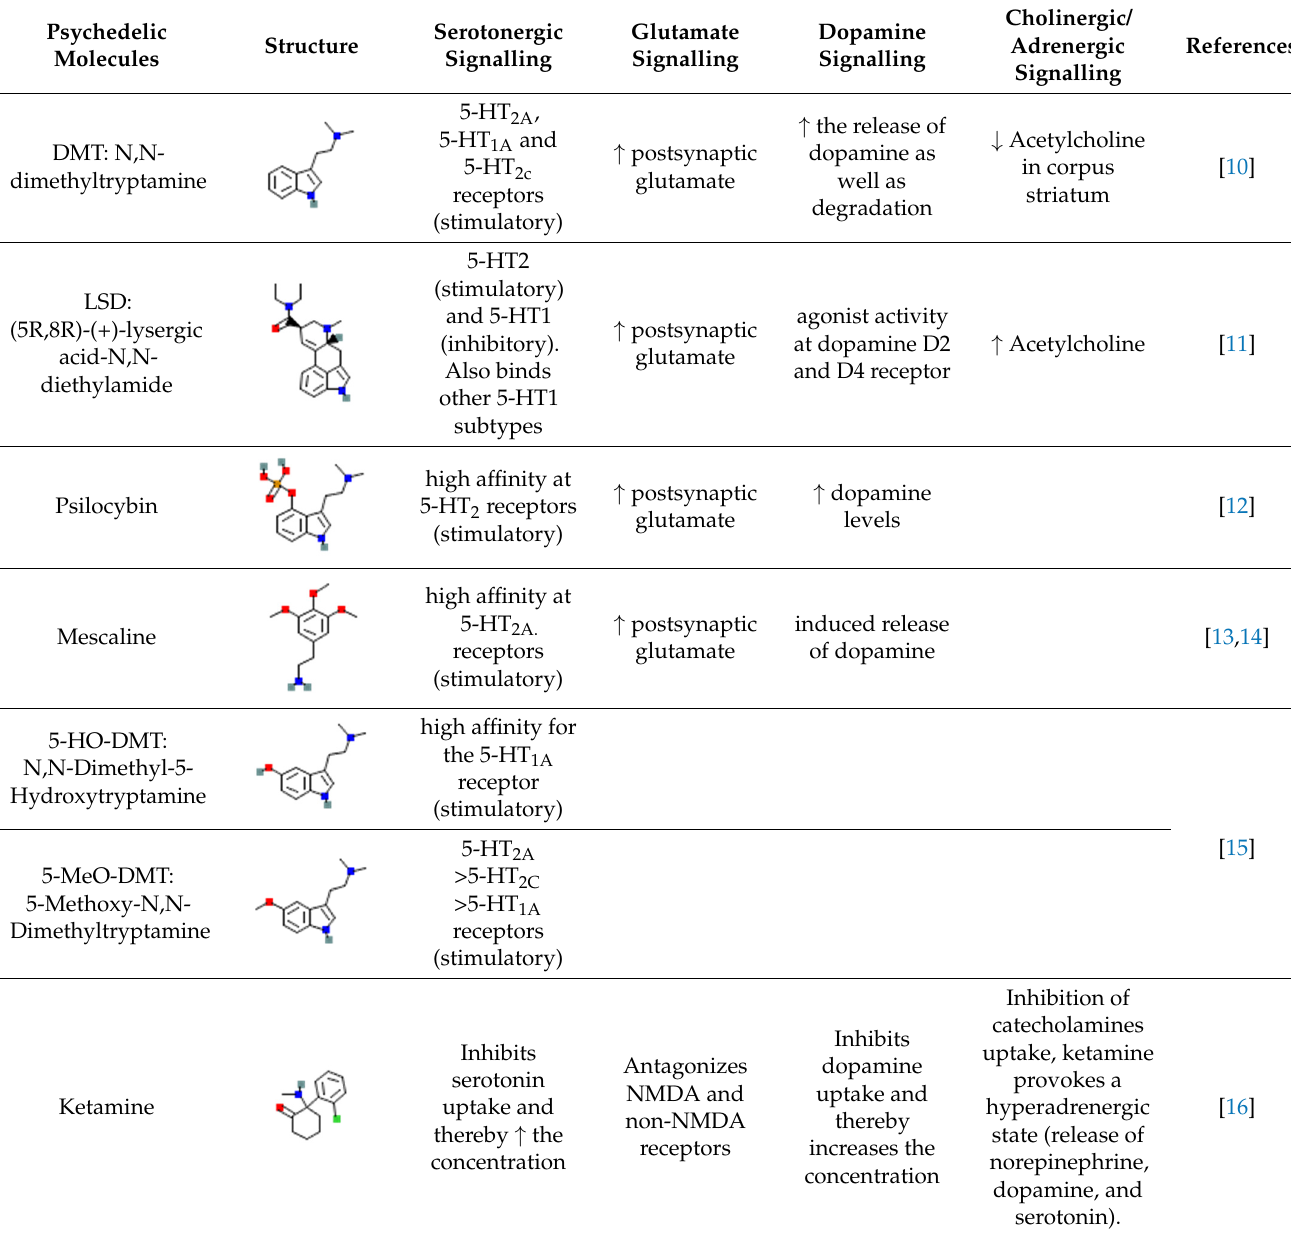
Table 1. Proposed molecular mechanism of action for psychedelic drugs. The target mechanism of action for each of the selected psychedelic drugs is manually integrated by curating published literatures. Mechanism of action is organized based on 4 major neurotransmitter signaling, which are well known in the literature to be affected by the psychedelic drugs. Images for each of the compounds are taken from the PubChem (light green colour indicates Hydrogen atom, blue colour for Nitrogen atom, red colour for Oxygen atom and the green colour for Chlorine atom). Up ( ↑ ) and down ( ↓ ) arrow indicates the increasing and decreasing levels of neurotransmitters in response to psychedelic molecules on each signaling pathways, respectively Abbreviations: 5-HT (serotonin), NMDA (N-methyl-D-aspartate).